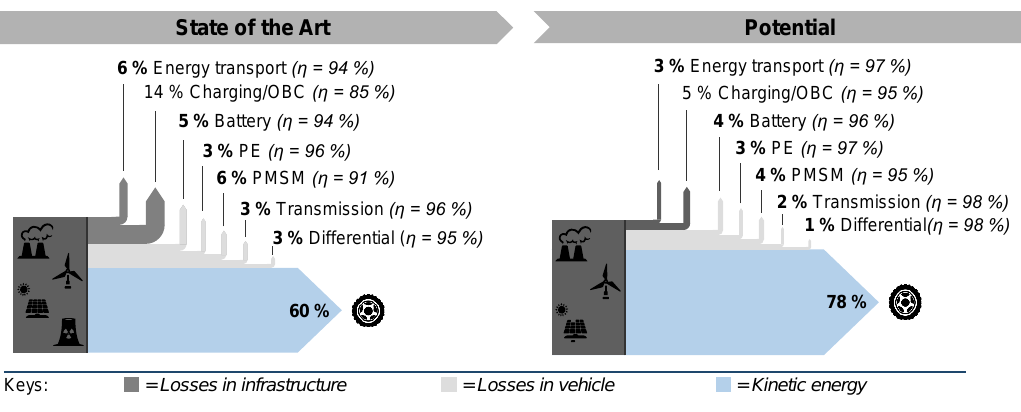
ffi ciency of the BEV with e ffi ciency data from Table Figure 7. Absolute WTW efficiency of the BEV with efficiency data from Table S3. Figure 7. Absolute WTW e